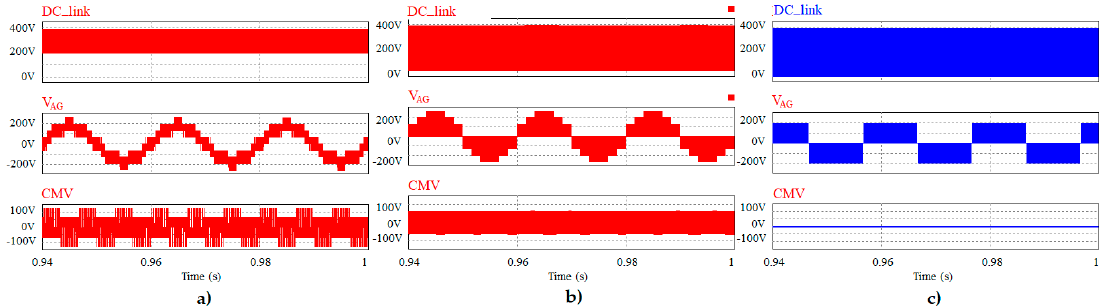
Figure 6. Simulation results of the DC-link voltage, phase voltage ( V AG ), and CMV. ( a ) Method 1, ( b ) method 2, ( c ) proposed method.